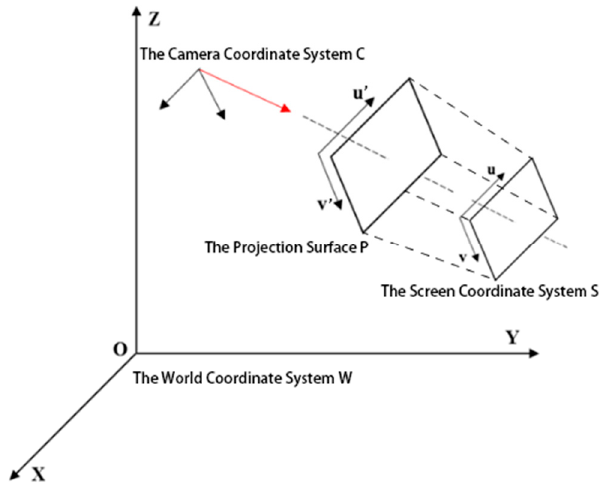
Figure 1. The relative position relations of the coordinates. The O-XYZ coordinate system is the world coordinate system; C is the camera coordinate system; P is the projection surface coordinate system; and S is the screen coordinate system.